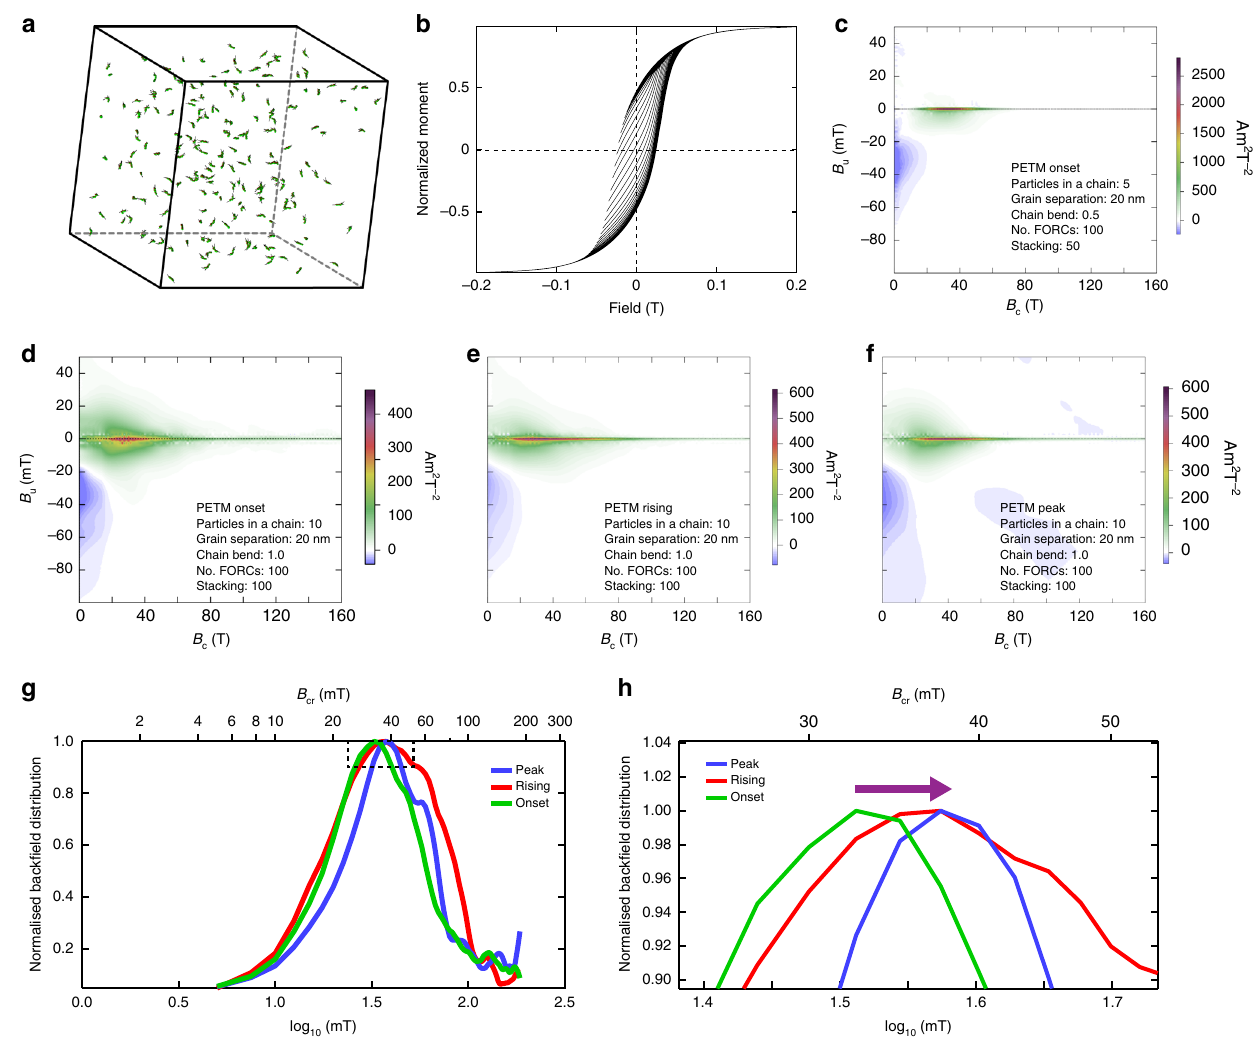
Fig. 5 Micromagnetic simulations of magnetofossils for samples from ODP Hole 1263C. a – c Micromagnetic simulation of FORC diagrams for PETM onset sample: a geometry, b simulated FORCs, and c processed FORC diagram. For input models, particle size distributions of biogenic magnetite are from TEM observations (Fig. 4). The magnetosome chain con fi gurations modelled in c are: 5 crystals in a chain, 60 chains, a chain bending factor of 0.5, a grain separation of 20 nm, and randomly oriented chains with packing fraction of 0.001 (ref. 44 ). d – f Micromagnetic simulation of FORC diagrams for the three PETM samples using model parameters: 10 crystals in a chain, a chain bending factor of 1.0 (collapsed chains) and a grain separation of 20 nm. The three simulations represent the samples for which experimental results are presented in Figs. 2 and 4. For all FORC simulations, we modelled 100 FORCs with B = 160 mT, B = 60 mT, and averaged 100 identical FORC simulations. Particles were selected randomly again from the TEM observations for each FORC c u simulation. FORC diagrams were processed using FORCinel 67 with VARIFORC smoothing parameters: 68 { s c0 , s c1 , s b0 , s b1 , λ c , λ b } = {7, 7, 2, 7, 0.1, 0.1}. g , h Back fi eld coercivity distributions extracted from the simulated FORC diagrams in d – f for the three PETM samples. h Data from the enlarged dashed box in g ; the arrow in h indicates the data